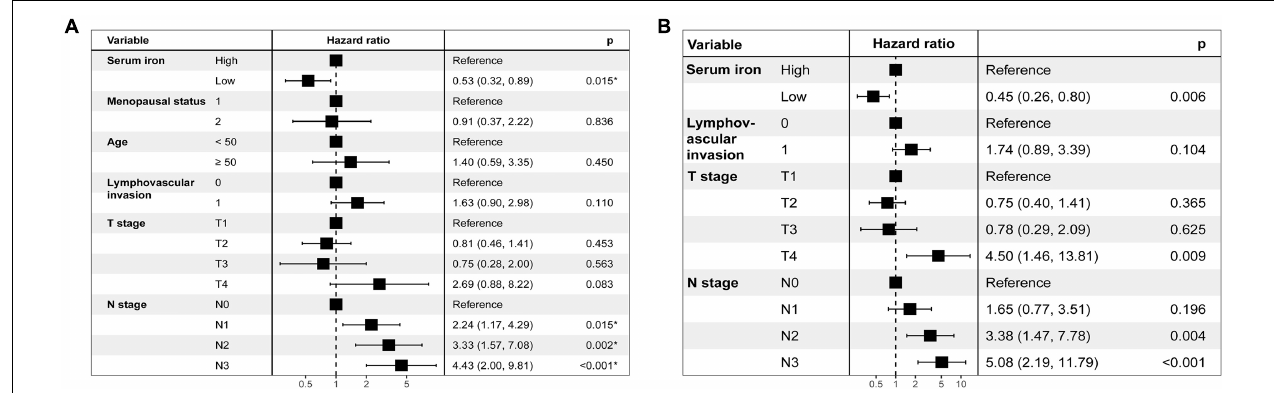
FIGURE 3 | Results of stepwise multivariate Cox models in the training cohort are showed as forest plots. (A) Forest plot of disease-free survival (DFS). (B) Forest plot of overall survival (OS).